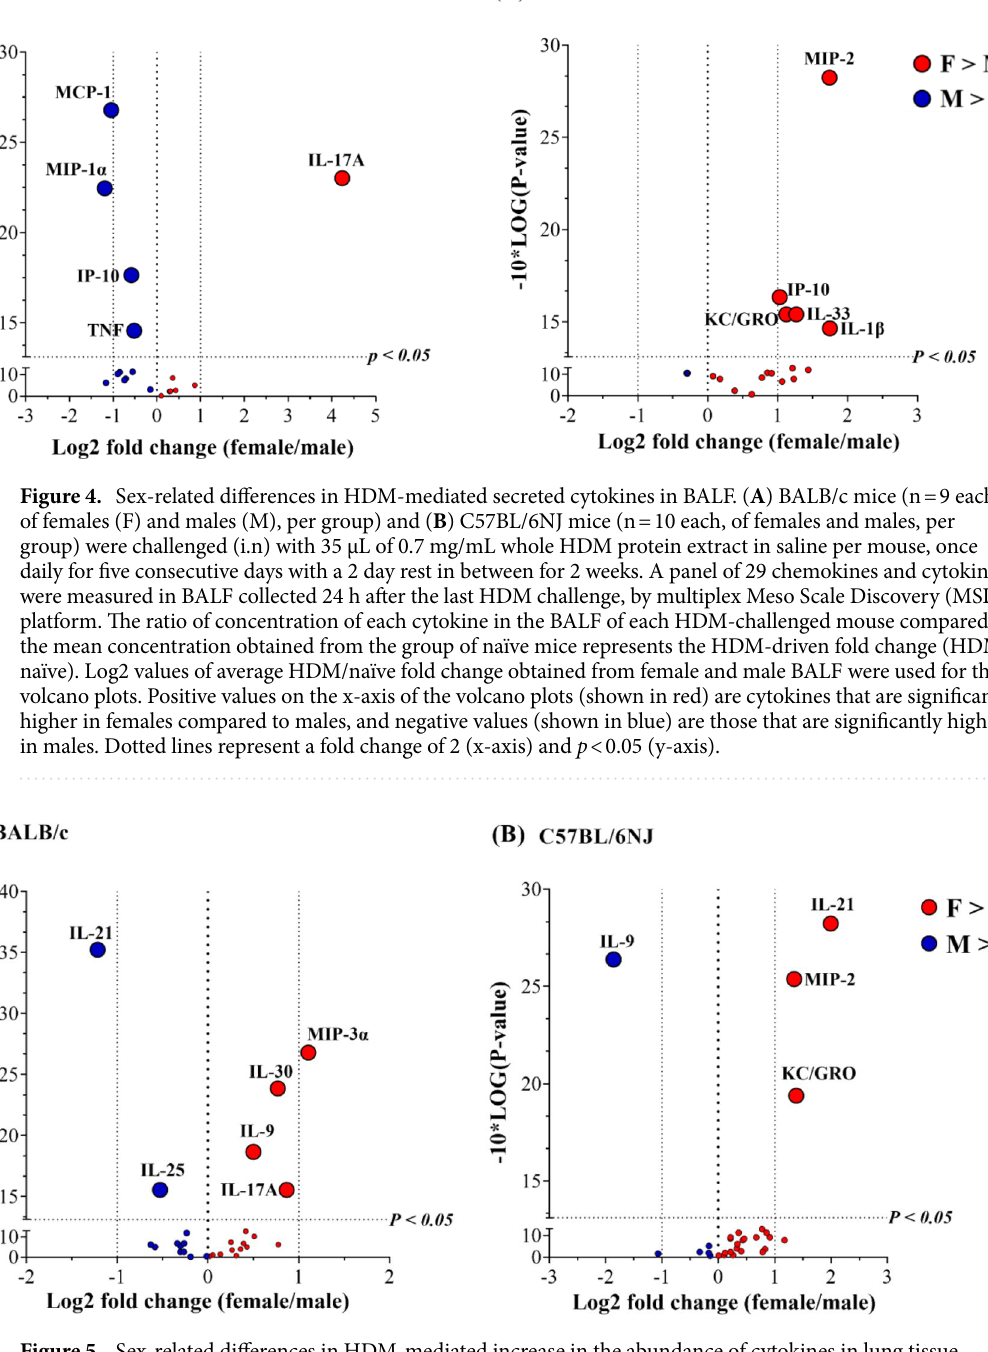
Figure 5. Sex-related differences in HDM-mediated increase in the abundance of cytokines in lung tissue lysates. ( A ) BALB/c mice (n = 9 each, of females (F) and males (M), per group) and ( B ) C57BL/6NJ mice (n = 10 each, of females and males, per group) were challenged (i.n) with 35 μL of 0.7 mg/mL whole HDM protein extract in saline per mouse, once daily for five consecutive days with a 2 day rest in between for 2 weeks. A panel of 29 chemokines and cytokines were measured in the lung tissue lysates collected 24 h after the last HDM challenge, by the multiplex Meso Scale Discovery (MSD) platform. The ratio of the abundance of each cytokine in the lung tissue lysates from each HDM-challenged mouse compared to the mean abundance obtained from the group of naïve mice represents the HDM-driven fold change (HDM/naïve). Log2 values of average HDM/ naïve fold change obtained from female and male BALF were used for the volcano plots. Positive values on the x-axis of the volcano plots (shown in red) are cytokines that are significantly higher in females compared to males, and negative values (shown in blue) are those that are significantly higher in males. Dotted lines represent a fold change of 2 (x-axis) and p < 0.05